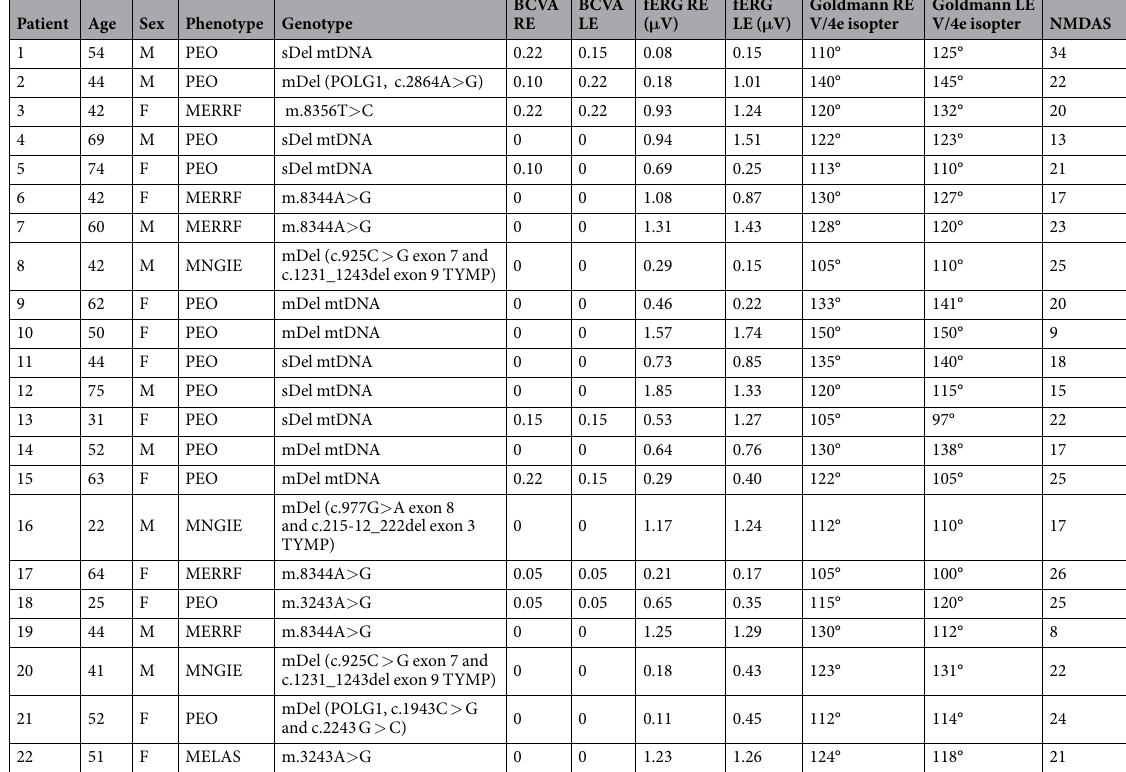
Table 1. Demographics and clinical data of patients with mitochondrial disease. (NMDAS: Newcastle Mitochondrial Disease Adult